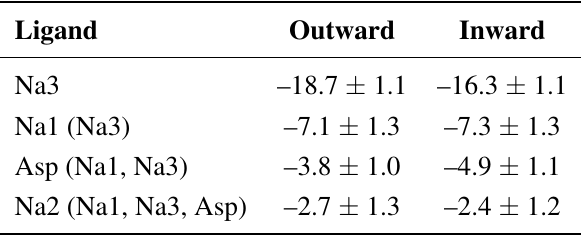
Table 1. Ligand binding free energies, ∆ G inward-facing conformations (units, kcal/mol). The ligands present during the free energy calculations are indicated in parenthesis (other combinations of ligands yield higher free energies, and therefore are not shown)